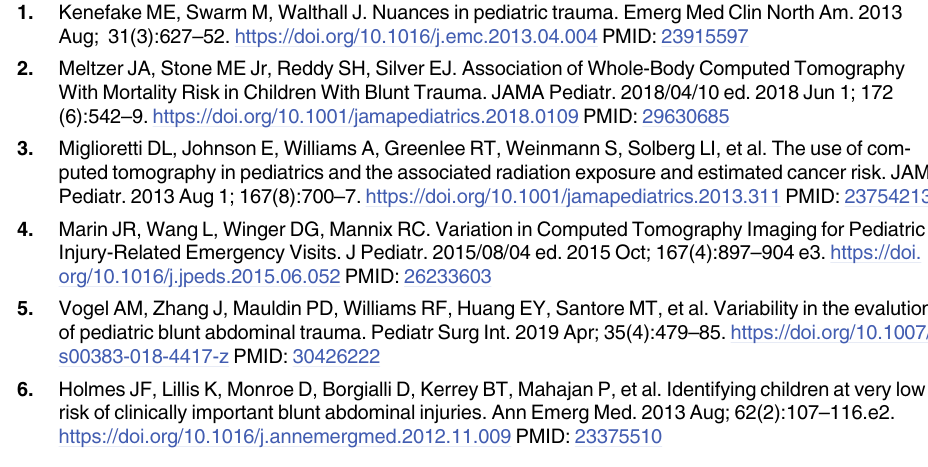
S5 Fig. Redundant predictor variables are compared in this heatmap of (a) all predictors and (b) subset of key predictors. Darker blue signifies a direct correlation. Darker red signifies an inverse correlation. White signifies no correlation. S6 Fig. Five stages of the Predictability Computability Stability (PCS) framework as adapted for clinical decision instrument assessment. First, the PCS framework (1) defines the clinical problem, then reviews all aspects of (2) collecting and preprocessing data, and (3) models clinical decision instruments using interpretable and rule-based models. Next, the PCS framework (4) performs a validity (predictability), stability, and validation analysis. Last, the PCS framework (5) supports the interpretation of the results by identifying limitations in all the PCS steps, ensuring clinical decision instruments are developed to be supported by both data and domain